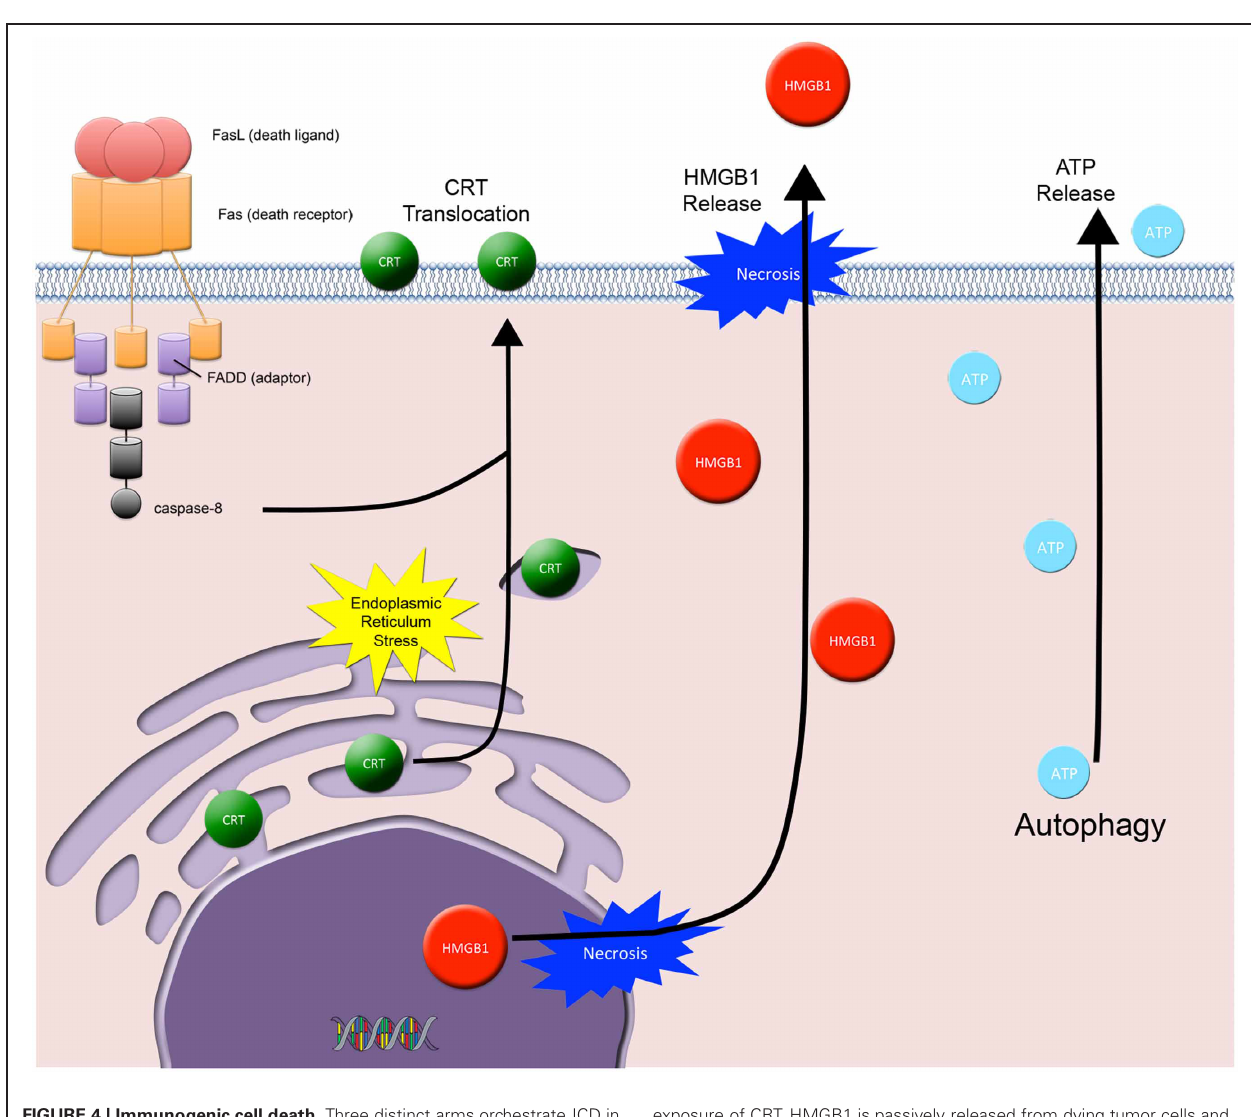
FIGURE 4 | Immunogenic cell death. Three distinct arms orchestrate ICD in dying tumor cells and are required for immune priming and activation: (1) the cell surface translocation of calreticulin (CRT) and the extracellular release of (2) HMGB1 and (3) ATP. CRT cell surface exposure acts as a dendritic cell “eat me signal” and involves the coordinated activation of 3 specific modules: ER stress, apoptosis, and ER-Golgi trafficking and extracellular